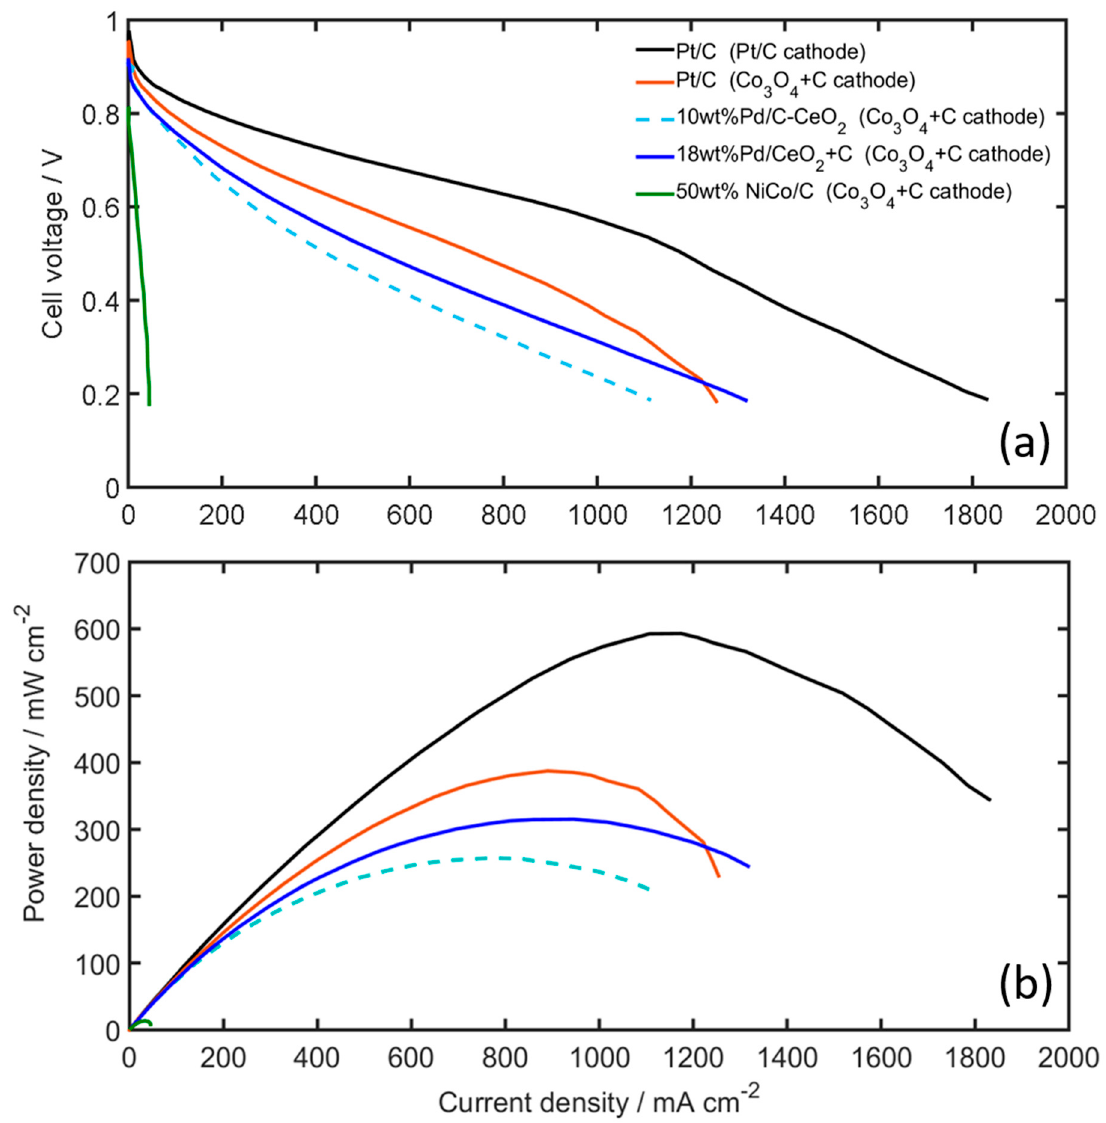
Figure 8. ( a ) Polarization, and ( b ) power density curves of the AEMFC using various anode and cathode catalysts (cathodes are denoted within parenthesis in the legend). Measurements taken at 70 ◦ C, H 2 and O 2 on anode and cathode, using 1.0 and 0.5 slpm, respectively. Gas dew points are 68 and 73 ◦ C for the anode and cathode, respectively.